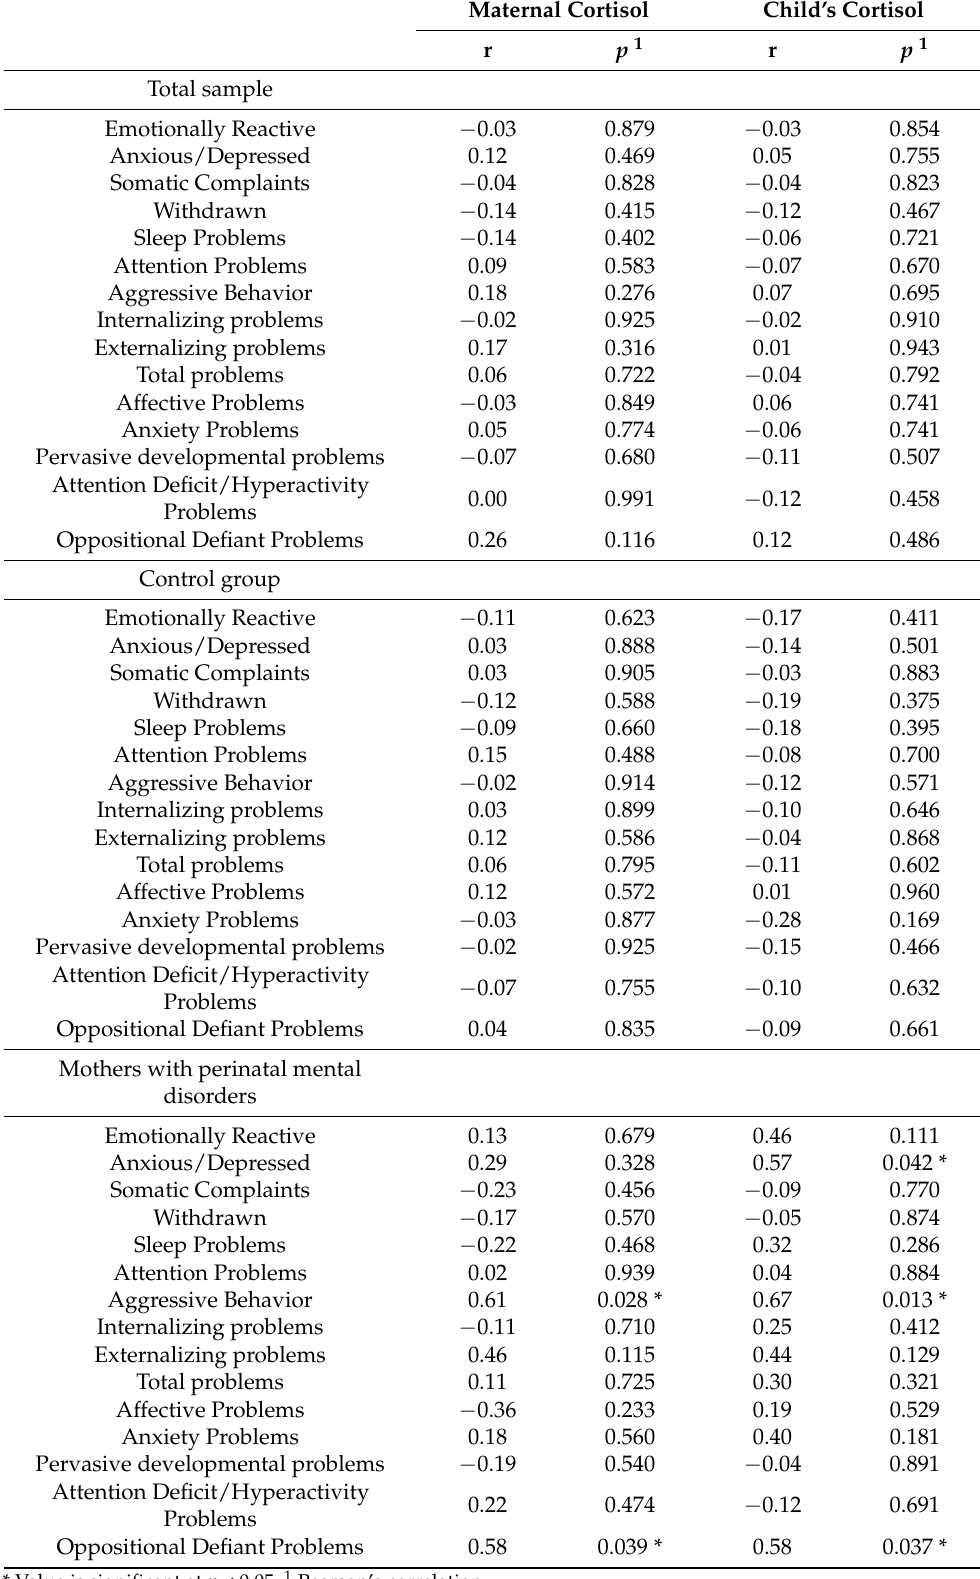
Table 3. Correlation among cortisol levels and child behavior check list